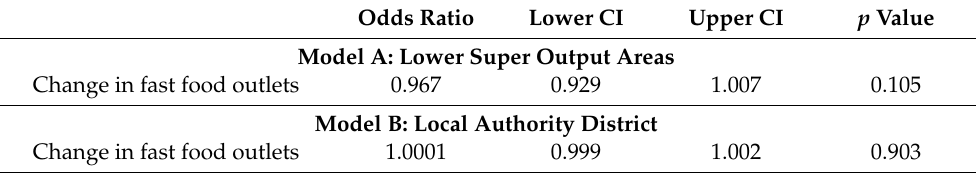
Table 2. Results from a logistic regression examining the association between change in number of fast food outlets and wave 6 overweight (adjusted for neighbourhood deprivation) in participants who migrated ( n = 1351). Note: CI = 95% Confidence